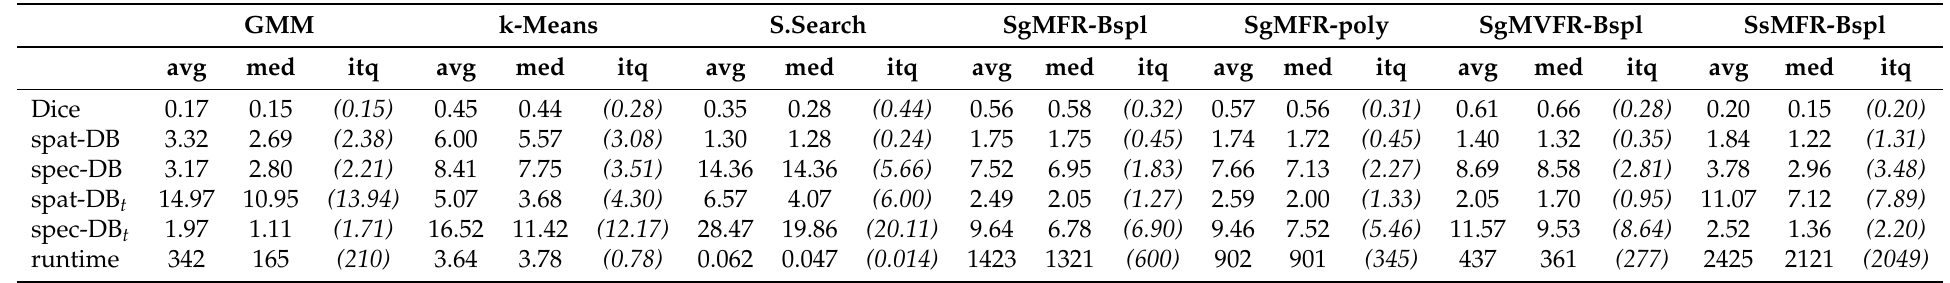
Table 1. Average median (interquartile range) of metrics and runtime over 81 patient scans. DB cluster separation index is computed for spatial content